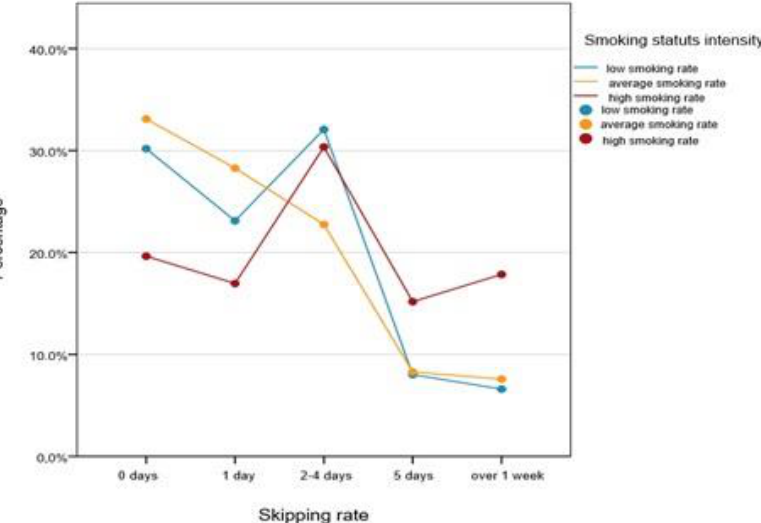
Figure 2. Percentage distribution of smoking students as a function of the numbers of days they skipped and the smoking intensity.